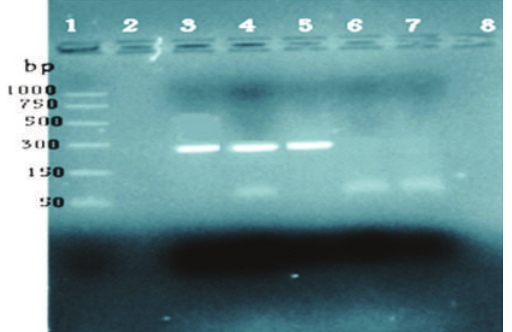
Figure 4: PCR product electrophoresis shows a band measuring 270 base pairs. Line 1: DNA ladder. Line 2: negative control. Line 4: patient no. 3. Lines 3 and 5 are positive controls for L. major .